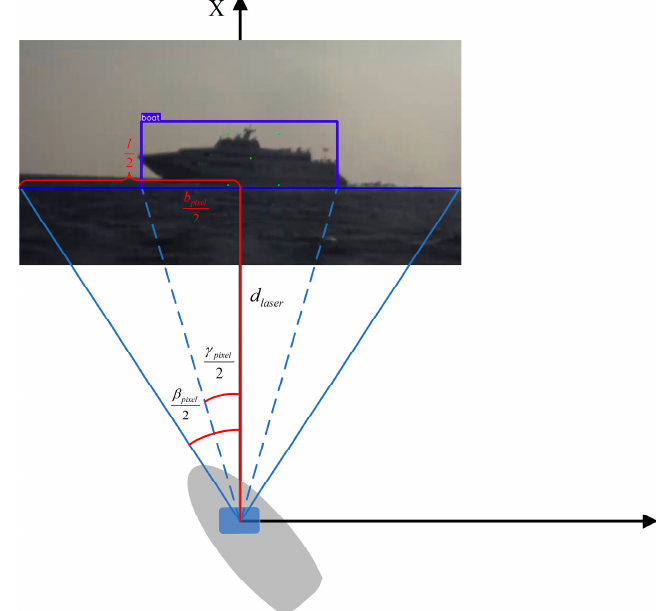
Figure 6. Secondary field-of-view adaption algorithm of the USV. Ten different maritime test environments are selected to test the field-of-view adap- tive algorithm. Comparing the first frame without field-of-view adaptive processing with the image with field-of-view adaptive processing shows that the object’s local feature de- tection accuracy is improved by 16.8%. 3. Scene Recognition Algorithm The scene recognition is an algorithm for the perception system to recognize the spe- cial scenes in the first frame image. After the photoelectric device has pointed to the object, the scene can be classified as follows, according to the characteristics of the image. The first is the single-object scene, where only the radar-guided object is in the image. The second is the different kind of multi-object scene, in which there are multiple objects but in different categories. The third is the multi-object scene of the same category. In this scene, there are multiple objects in the same category. The fourth is the green-water scene, where the water blocks the object. The fifth is the mast-obscuration scene, where the mast occludes the object. The perception system cannot identify and detect the object if the scene is the green-water scene or the mast-obscuration scene. 3.1. Recognition of the Mast-Obscuration Scene The radar-guided object, the mast of the USV, and the photoelectric device are in a straight line when the scene of the first frame image is the mast-obscuration scene. As shown in Figure 7, it is the images of the mast-obscuration scene. The perception system cannot identify and detect the object when the scene is the mast-obscuration scene.